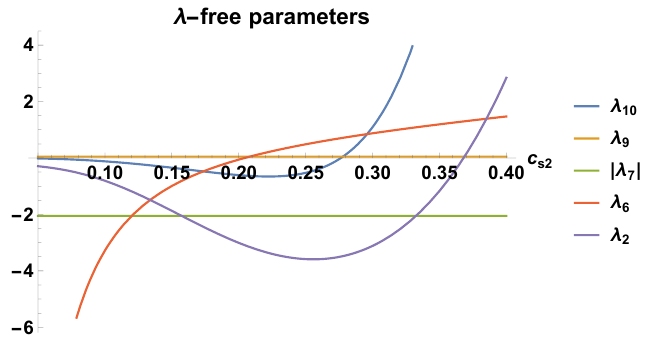
Figure 2 . Plot of the particular λ 2 , 6 , 7 , 9 , 10 functions used to make the total squeezed f NL slightly dependent on c in a region c 0 . 3 . s 2 s 2 ≤